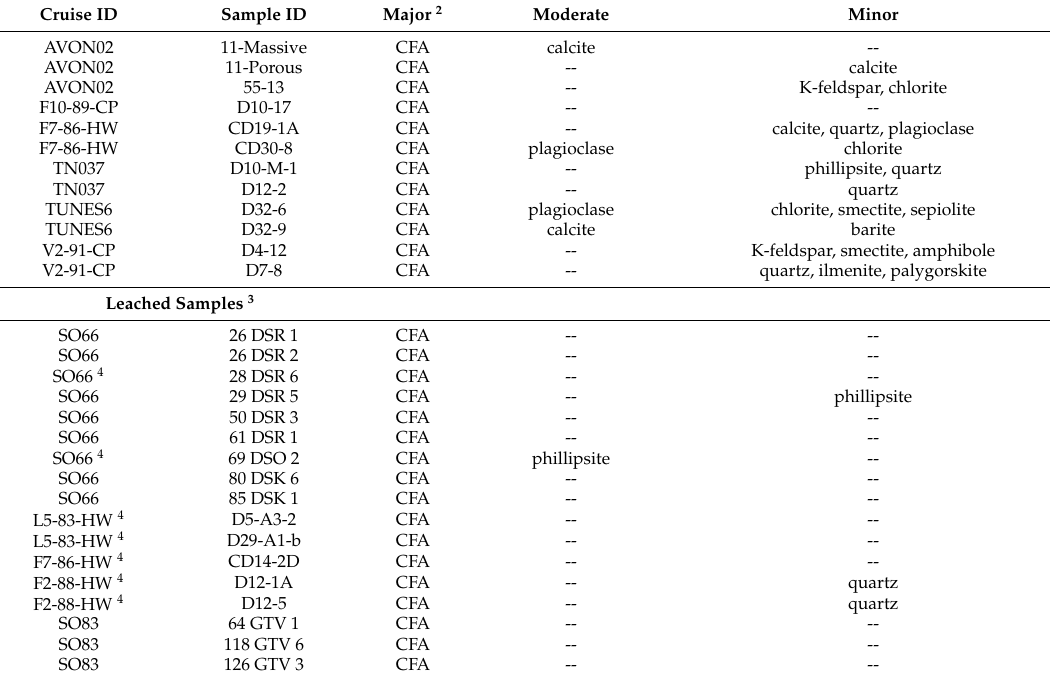
Table 1. XRD mineralogy of phosphorites from seamounts 1